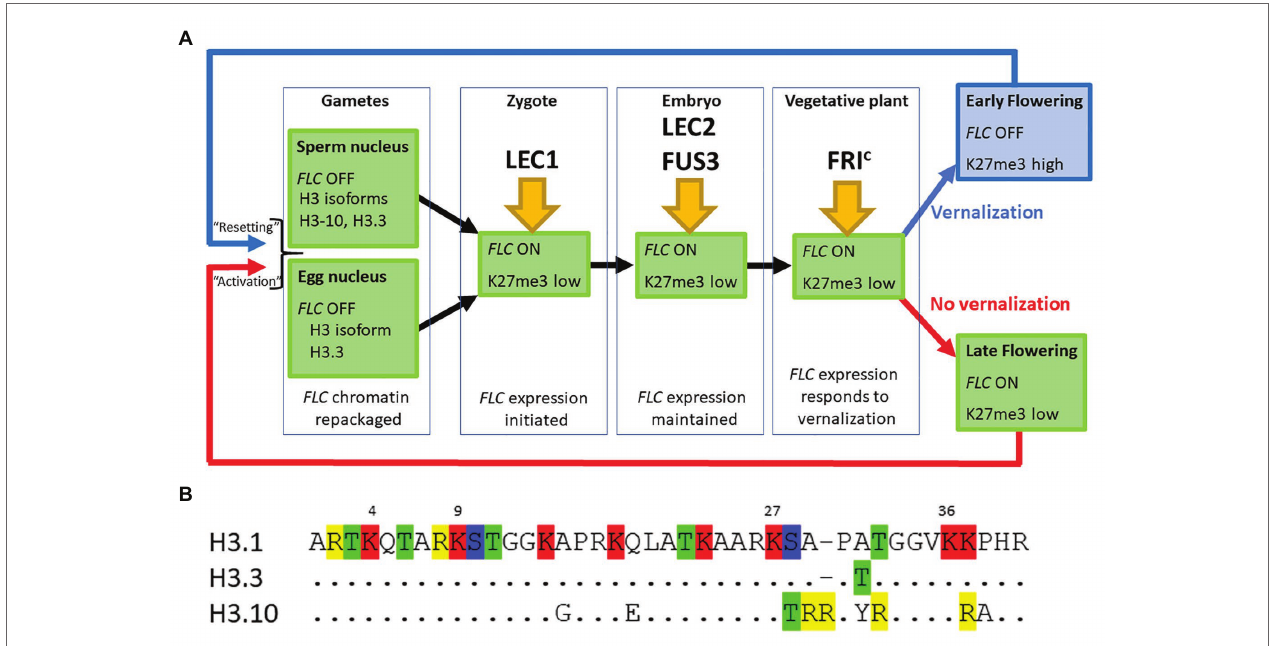
FIGURE 1 | (A) FLOWERING LOCUS C ( FLC ) expression is established in the zygote and maintained through the life of the plant unless the plant becomes vernalized by exposure to prolonged cold during winter. FLC is inactive in mature gametes of both vernalized and non-vernalized plants where the chromatin is repackaged and epigenetic marks are lost. The major transcription factors determining FLC expression at each developmental stage are indicated. (B) The first 40 amino acids of three different isoforms of Histone H3 are shown. Single letter nomenclature is used and the dots shown in H3.3 and H3.10 indicate that the sequence is conserved with H3.1. The commonly methylated lysines are numbered above the sequence. Amino acids that can be modified are highlighted; R, me; T, ph; K, ac/me; S, ph. H3.10 and H3.3 each have the potential for novel modifications not seen in H3.1 and the substitution S-T28 (H3.10) may disrupt the activity of the kinase that normally phosphorylates that position. The changes adjacent to K27 may also prevent methylation of that residue. H3.1 denoted the protein encoded by HTR3 , H3.10 by HTR10 , and H3.3 by HTR5 .